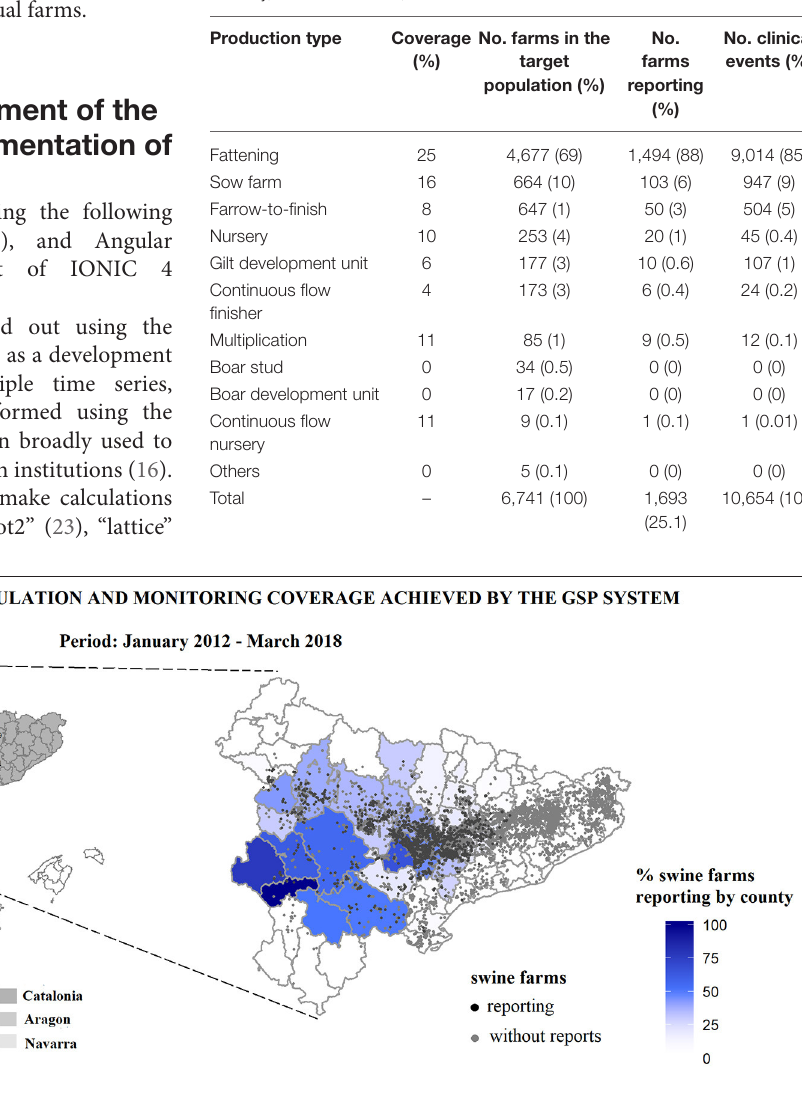
Frontiers in Veterinary Science |